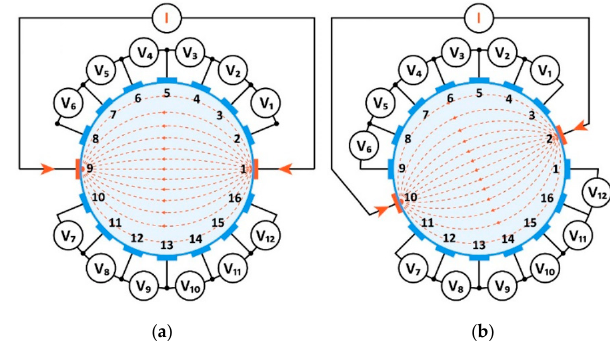
Figure 4. The opposite method of voltage measurement in a system of 16 electrodes [1]: ( a ) first measurement cycle, ( b ) next measurement cycle.